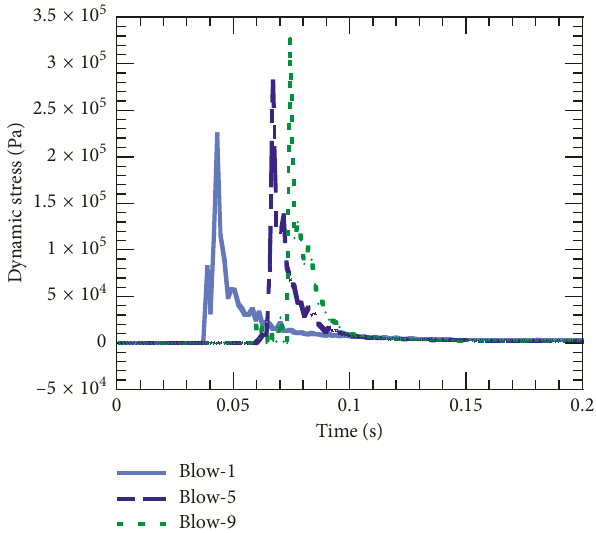
Figure 6: Time-stress curve of the bottom of the